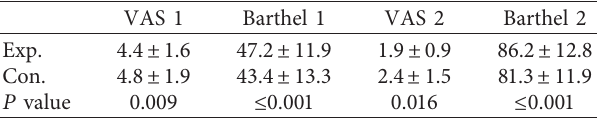
Table 4: Comparison of VAS and Barthel index one week and six weeks after operation in both experiment and control groups.